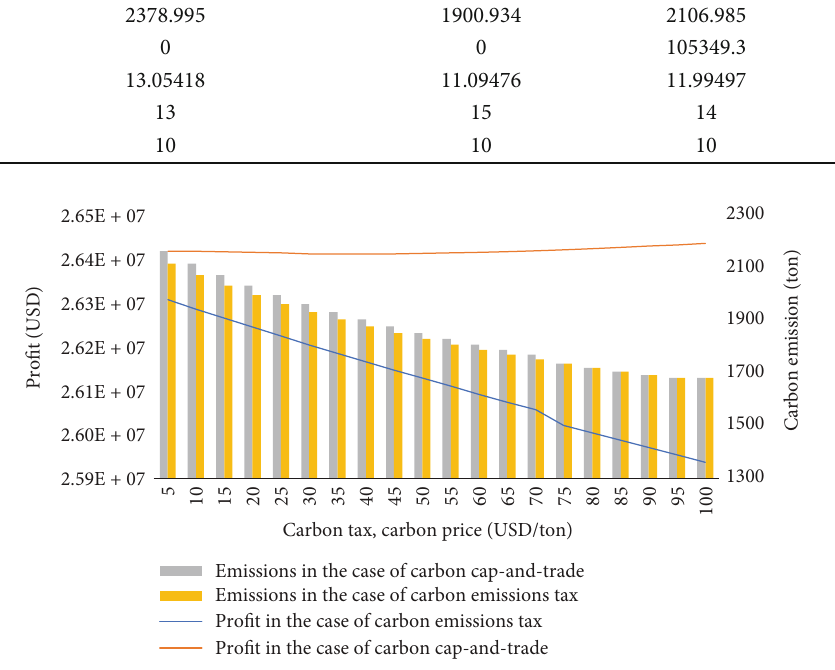
Figure 3: Results for comparison of carbon emissions tax and carbon cap-and-trade.